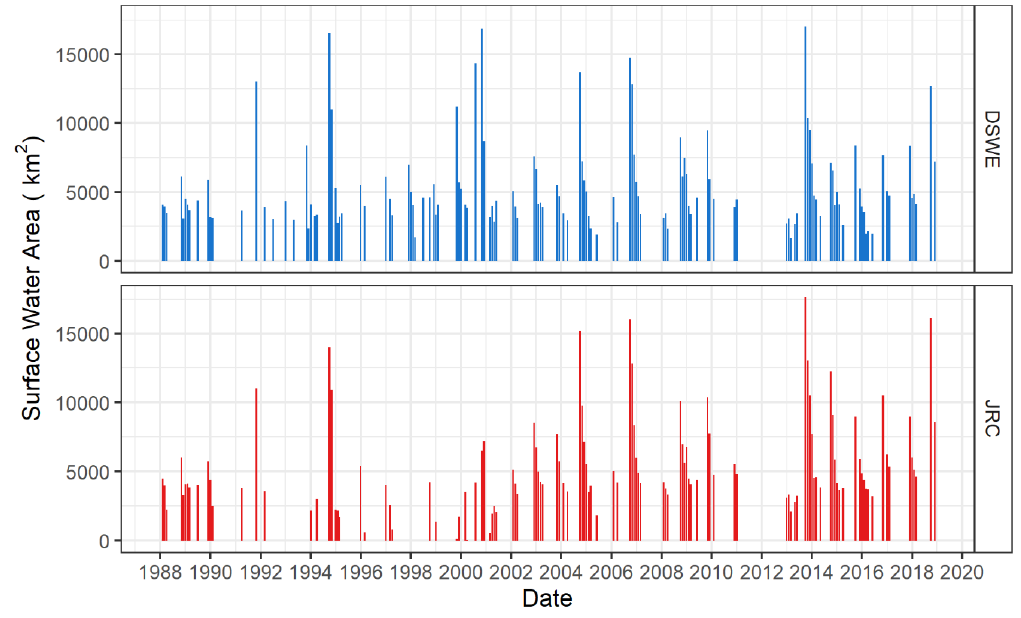
Figure 7. Monthly surface area estimates of DSWE Class 1—‘high-confidence’ water (top)—and JRC Class 2—‘water presence’ class (bottom)—for all of Cambodia, 1988–2018. The time series consists of months in which DSWE composites met minimum clear-sky and Landsat data coverage requirements. JRC data were not produced in 14 months; in 8 additional months, JRC’s total surface water area was <1,000 km 2 .